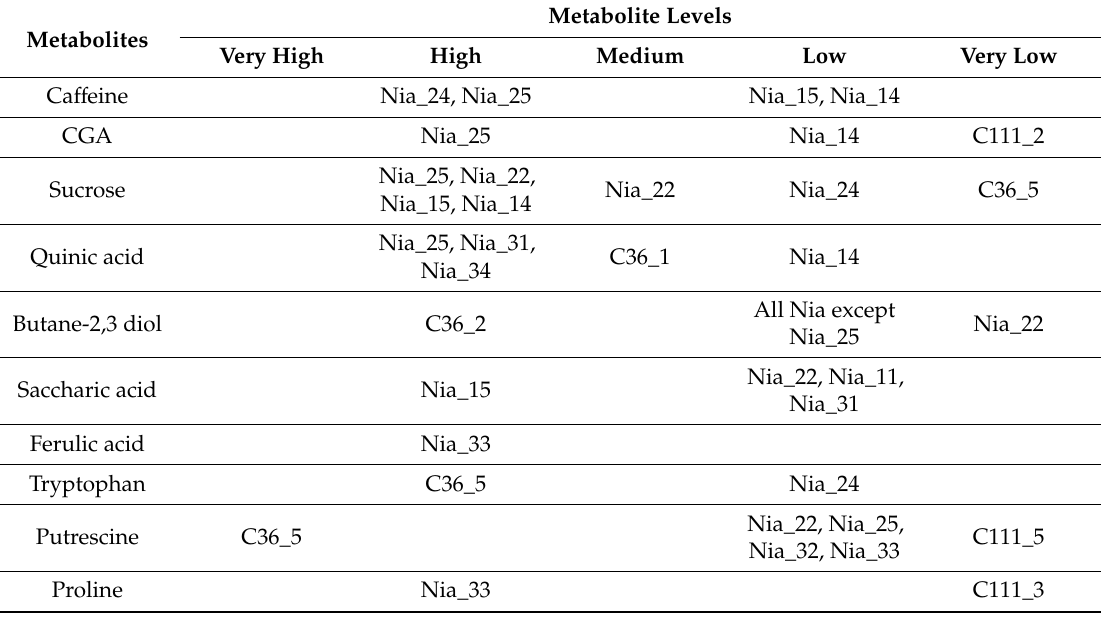
Table 3. Genotypes grouped based on the relative levels of the key metabolites identified from hierarchical analysis (Figure 6).